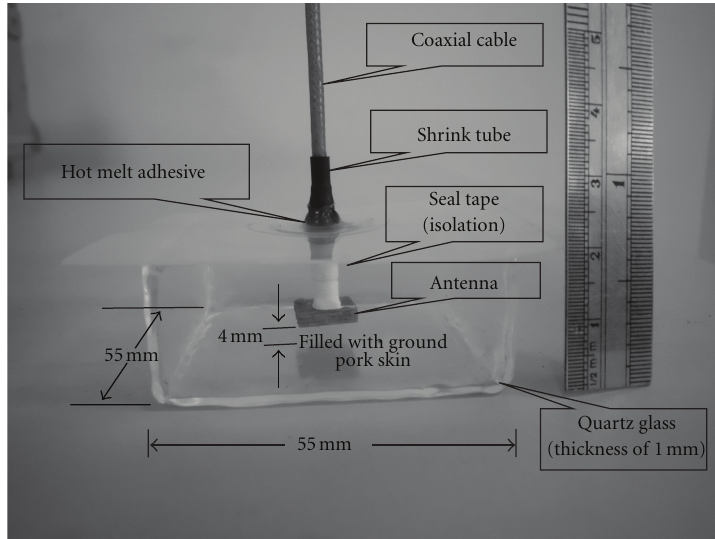
Figure 6: The structure and dimension of the